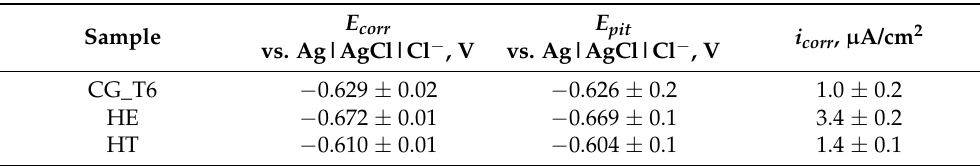
Table 3. Average electrochemical parameters: corrosion potential ( E corr ), pitting potential ( E pit ), and corrosion current density (i corr ) obtained from potentiodynamic curves. Figure 4. Potentiodynamic polarization curves of the 7475 Al alloy in an aerated 0.1 M NaCl.